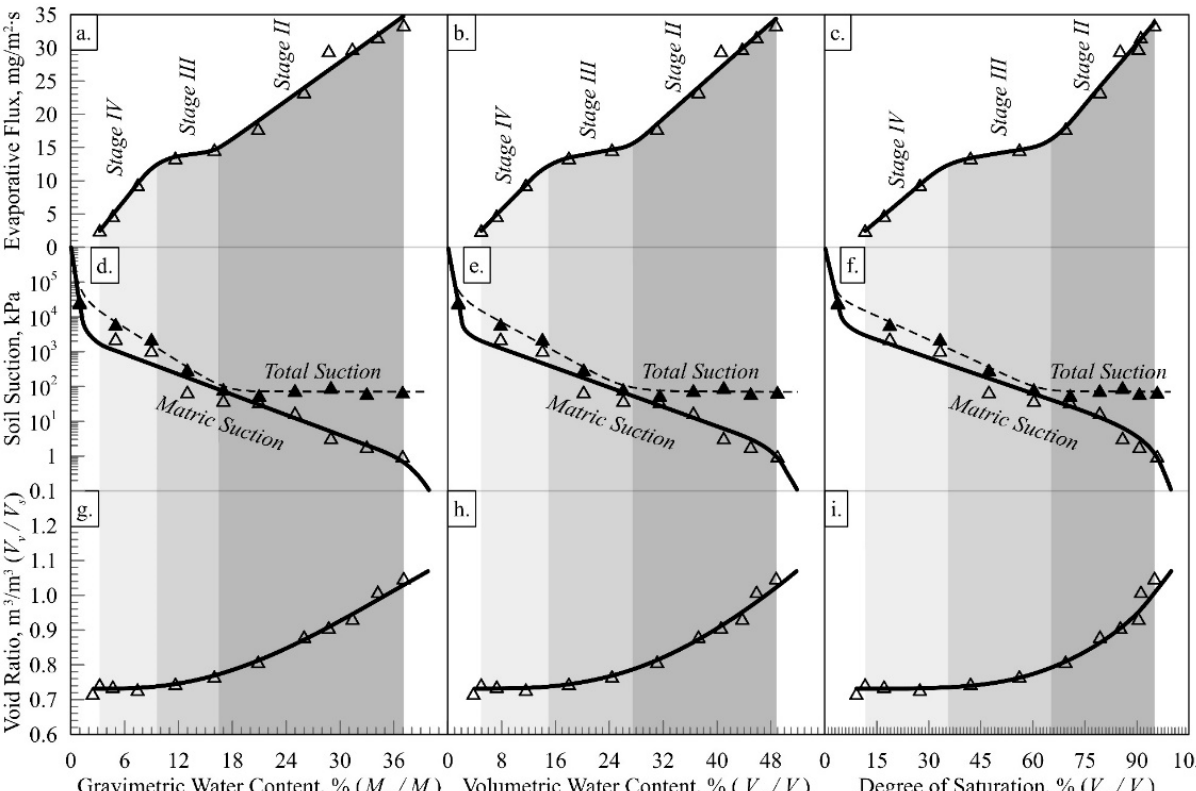
Figure 7. Behavior of lean clay under low atmospheric demand.